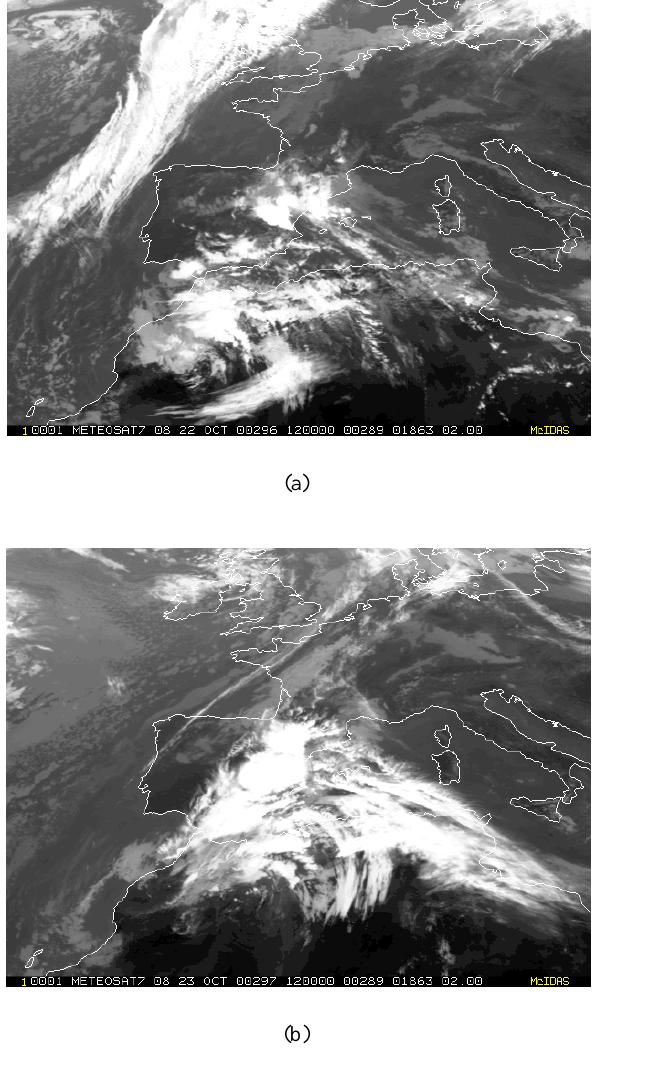
Fig. 5. Meteosat satellite infrared images on 12:00UTC (a) 22 and (b) 23 October 2000.